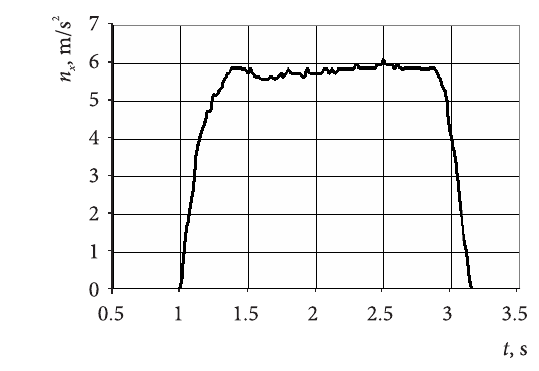
Fig. 1. Th e braking graph of AUDI 80 car